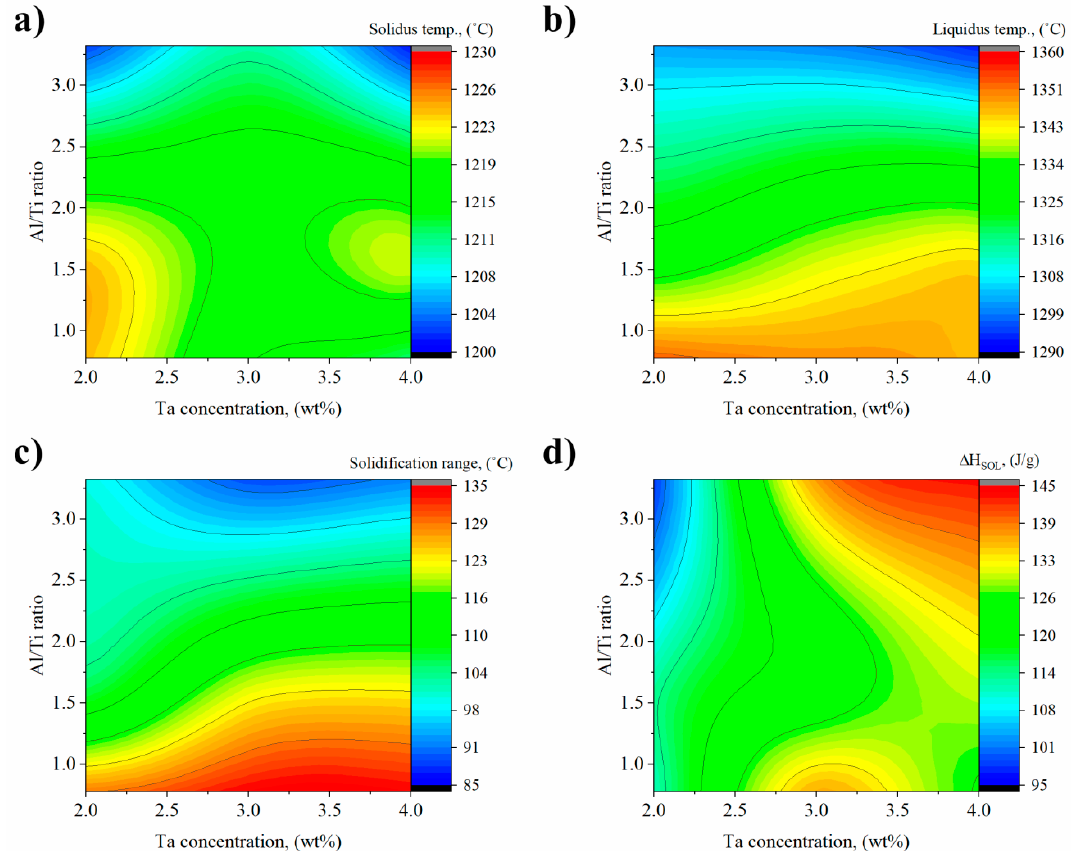
Figure 14. Influence of Al / Ti ratio and Ta concentration in modified alloys on: ( a ) solidus temperature; ( b ) liquidus temperature; ( c ) solidification range; ( d ) enthalpy of solidification.